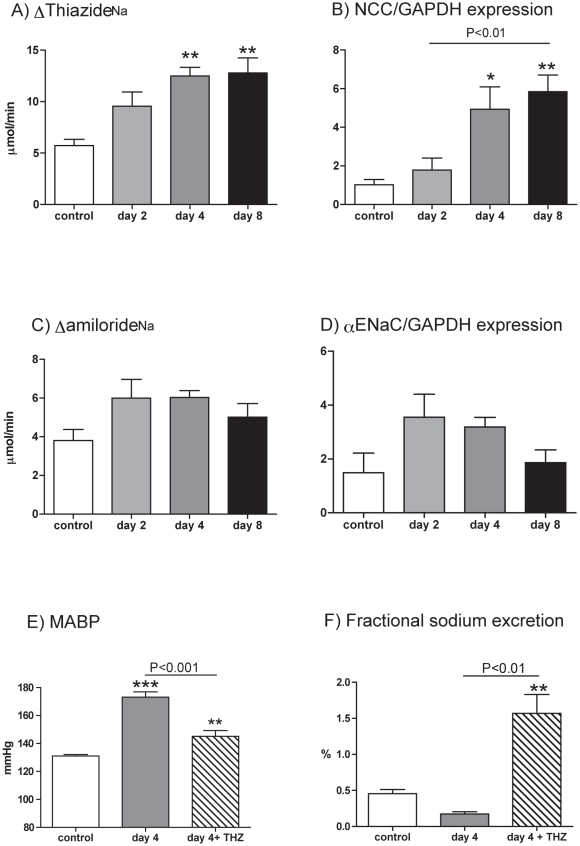
Sodium transport pathways in the aldosterone-sensitive distal nephron.A) hydrochlorthiazide-sensitive sodium reabsorption (ΔthiazideNa); B) the expression of the thiazide-sensitive co-transporter protein (NCC) in whole kidney extracts, normalized to that of GAPDH; C) amiloride-sensitive sodium reabsorption (ΔamilorideNa); D) the expression of the α subunit of the epithelial sodium channel (αENaC) normalized to that of GAPDH. Measurements were made in cyp1a1-Ren2 transgenic rats, on either day 2 (n = 9), 4 (n = 9) or 8 (n = 9) in the induction regimen. Non-induced rats (n = 8) served as control. E) mean arterial blood pressure (MABP) and F) fractional sodium excretion. Measurements were made in cyp1a1-Ren2 transgenic rats receiving either vehicle (grey bar) or hydrochrorothaizide (hatched bar) by minipump. Data are mean ± SE. Statistical comparisons were made using ANOVA with Bonferroni post-test. P<0.001, **P<0.01, *P<0.05 versus the control group.